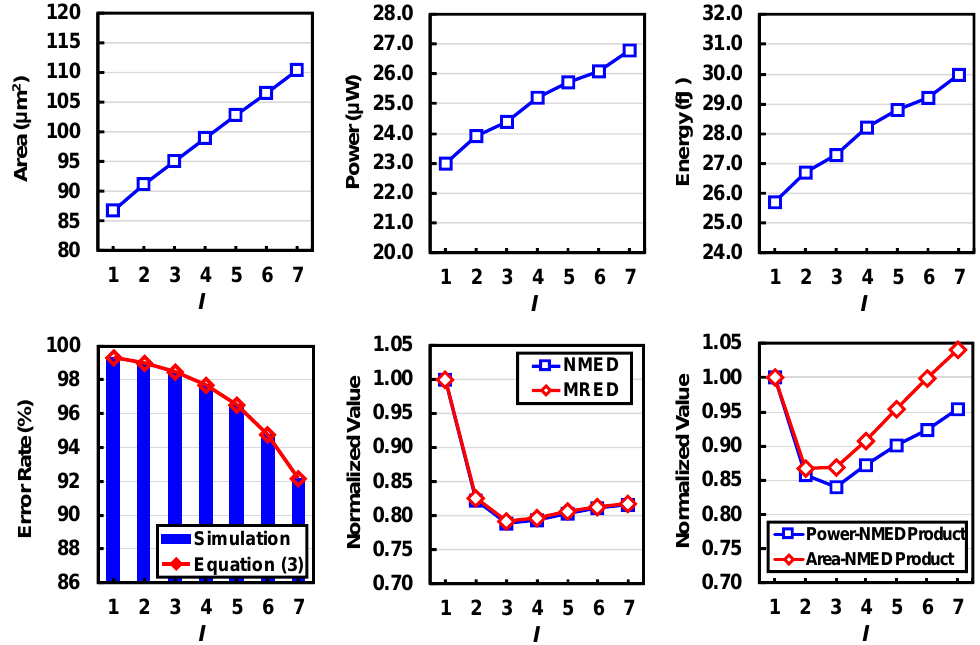
Figure 3. Performance analysis of the proposed adder under various values of l , ranging from 1 to